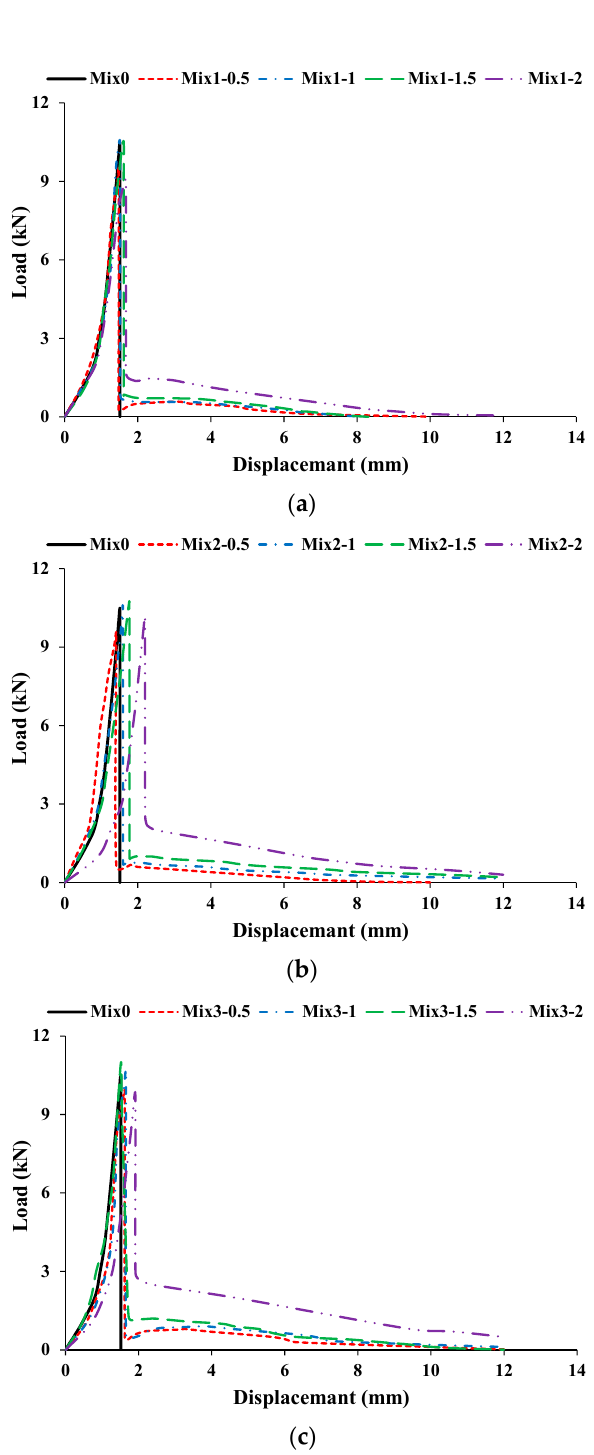
Figure 12. Load-displacement curves for HSC and CFR-HSC beams with ( a ) 25, ( b ) 50, and ( c ) 75 mm long fibers .